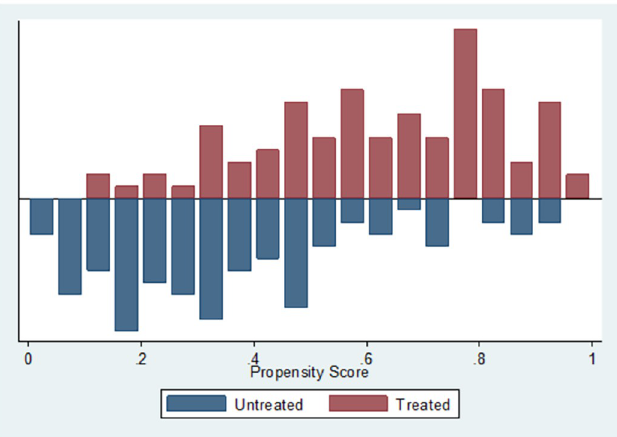
Fig 1. Common support region graph. Source: Computed based on Household Survey 2019.